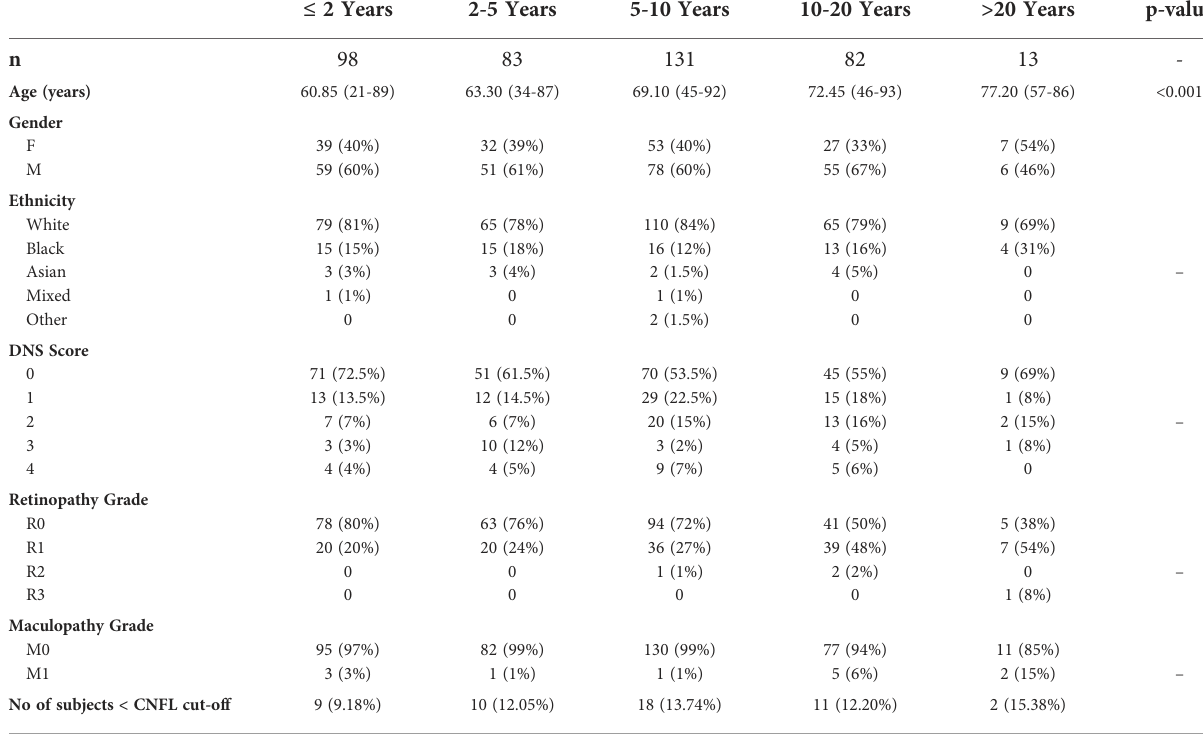
TABLE 5 Comparison of groups based on years since